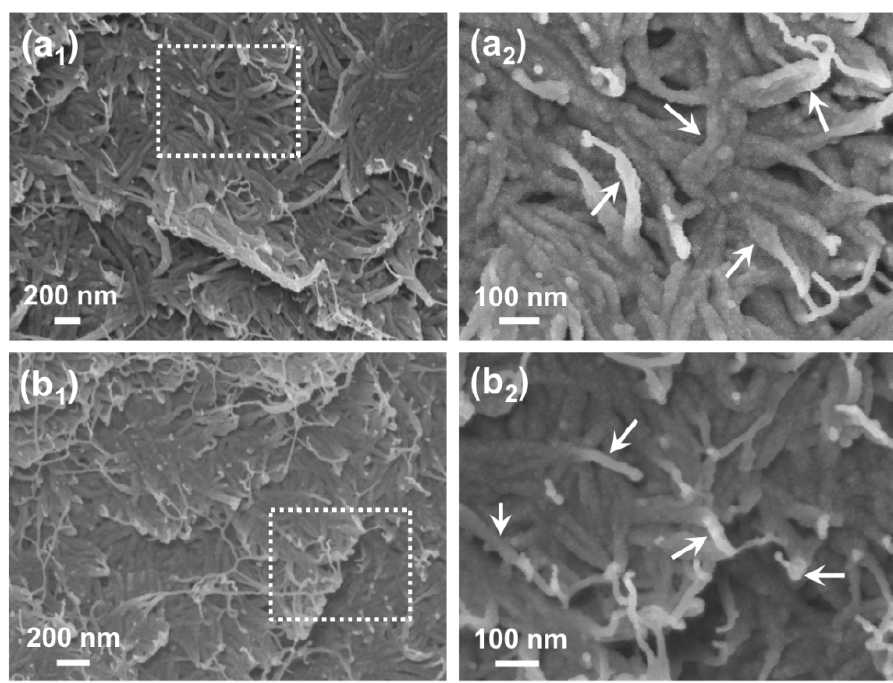
Figure 6. SEM images (without any metallic coating) of freeze-dried paste from the PRL for a 1:1 PAN:SWNT sample showing ( a 1 , b 1 ) SWNT/PAN networks, as well as ( a 2 , b 2 ) magnified images of these regions. The arrows point out the well-covered SWNT bundles.